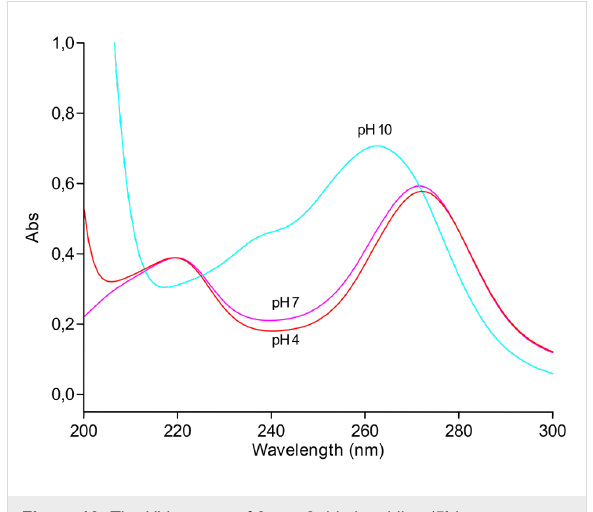
Figure 10: The UV spectra of 6-aza-2-thiothymidine ( 5b ).